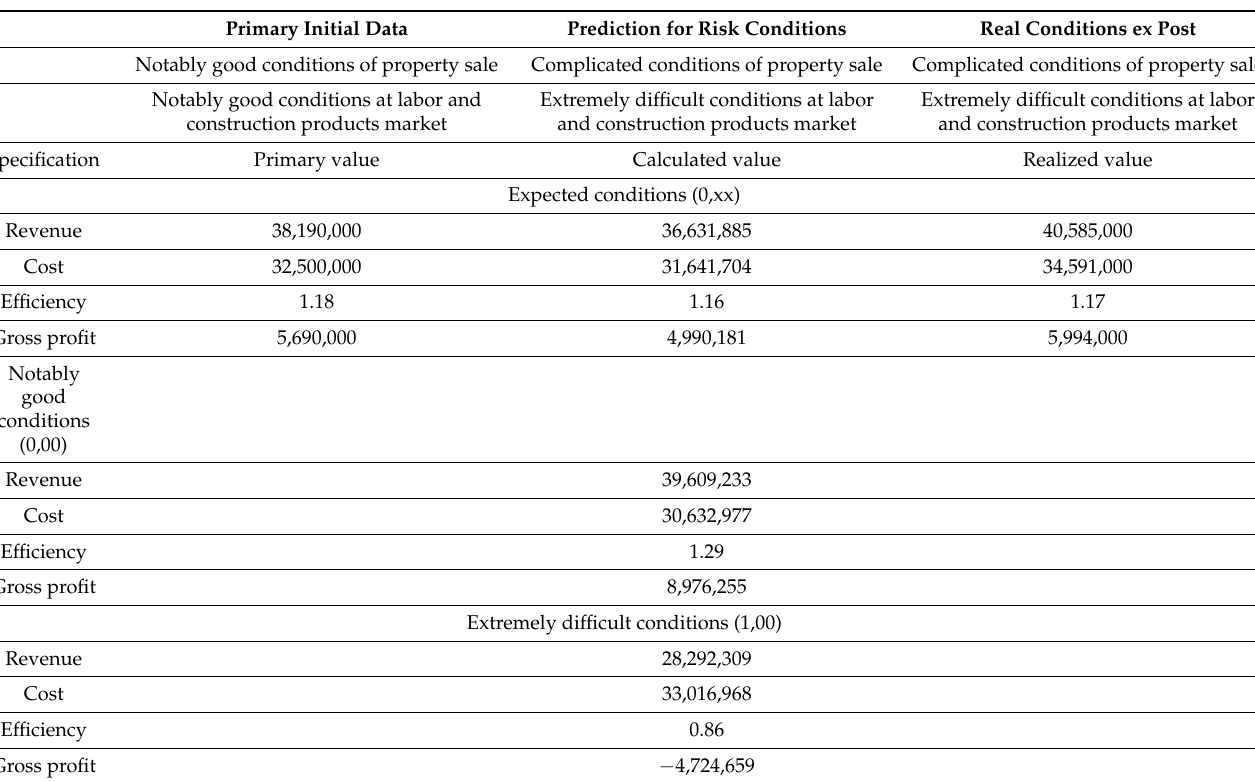
Table 7. Final results for conditions initially planned, actually expected, and really occurred for investment 3.